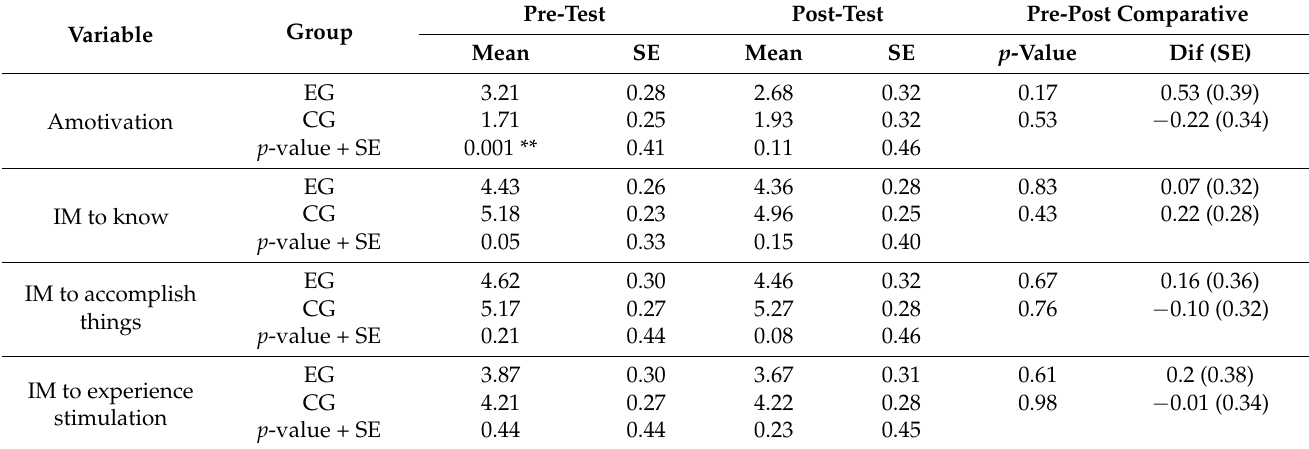
Table 3. Intervention multivariate analysis